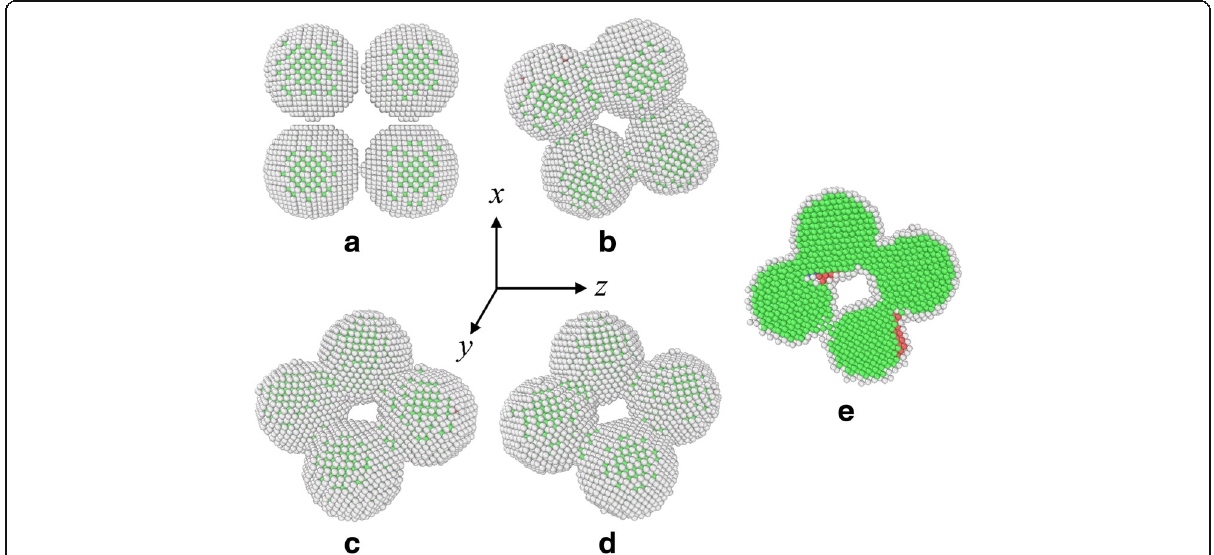
Fig. 2 Nanostructure evolution and rotation of silver nanoparticles during solid state sintering at 298 K. a 0 ns. b 0.34 ns. c 0.68 ns. d 1.00 ns. e Sectional view at 1.00